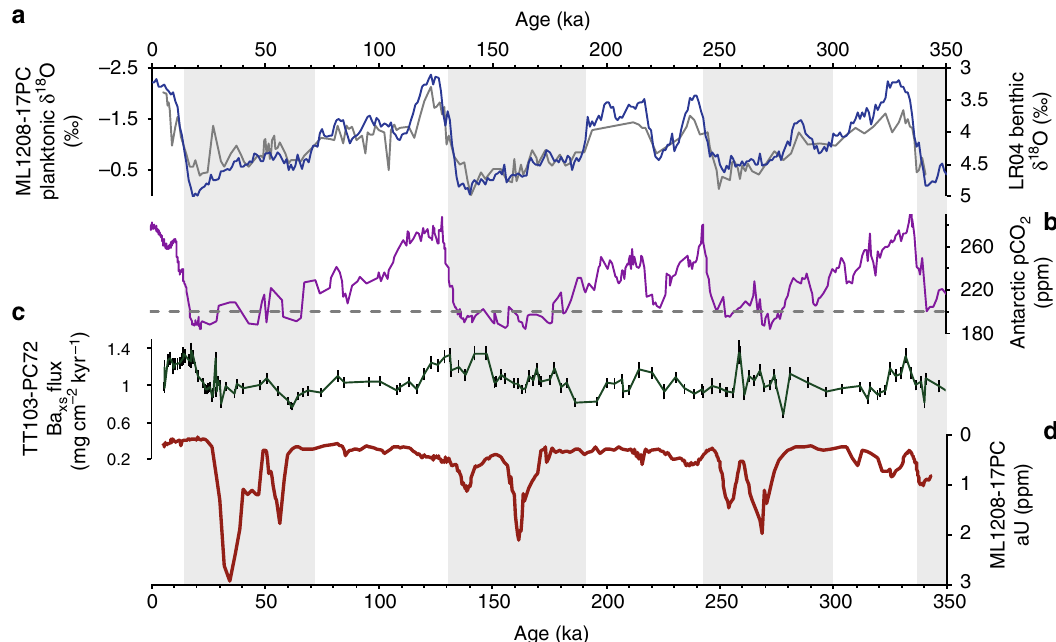
Fig. 3 Climate and aU. Benthic oxygen isotope stack (blue) 61 and local planktonic oxygen isotope stack from ML1208-17PC (grey) (this study) a . Composite of Antarctic pCO 2 records 73. b . Central equatorial Paci fi c Ocean (TT013-PC72) excess barium fl uxes (dark green) with 1 σ error bars 32. c . Authigenic uranium concentrations from site 17PC in the central equatorial Paci fi c Ocean (note the inverted y axis) with average 1 σ error bar indicated. d . All Antarctic records are on the AICC2012 age model 74 and all other records are as originally published. Grey bars indicate glacial climate